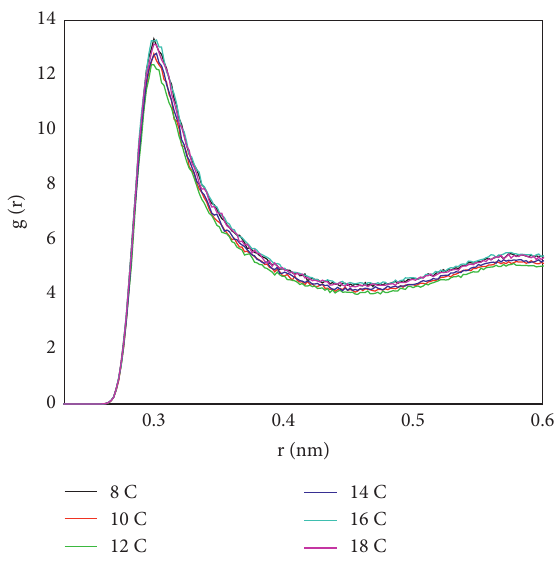
Figure 11: Radial distribution function between O